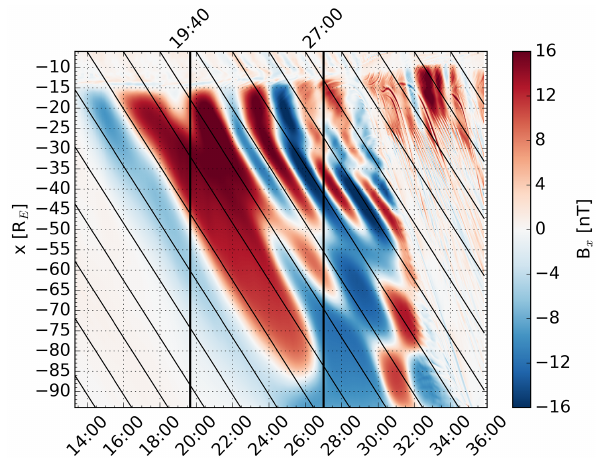
Figure 1. Ratio of ion thermal pressure perpendicular to the mag- netic field and magnetic pressure β ⊥ = P thermal , ⊥ /P magnetic and magnetic field lines in the x − z plane at 19:40 (1180 . 0s). Closed field lines are drawn in green, semi-open field lines in black, and open field lines in gray. Field lines that are closed but not attached to the geomagnetic field are drawn in magenta. The tail lobes are estimated to lie between the blue curves. The curves indicate the innermost boundaries where β ⊥ > 1 in the region | z | > 5 R E and x < 0. Inside the red box, a hemispherically asymmetric magne- topause perturbation compresses the northern tail lobe and expands the southern tail lobe, causing the current sheet between the tail lobes around x = − 40 R E to shift slightly southward from its nom- inal position at z = 0.